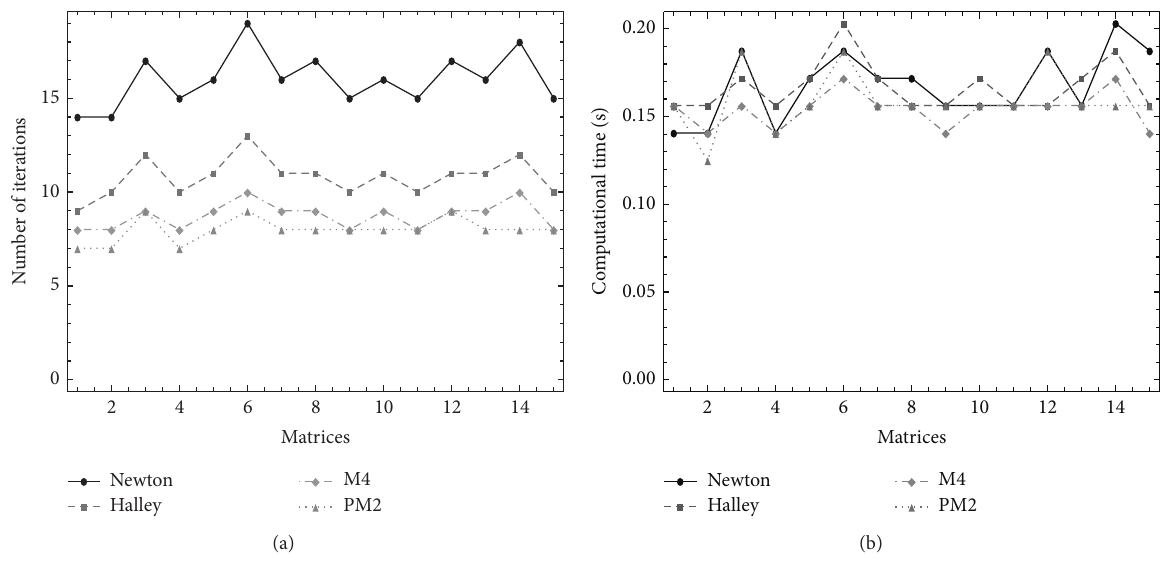
Figure 4: The comparisons of different matrix iterations in terms of the number of iterations and the computational time for 15 different test matrices in Example 2.